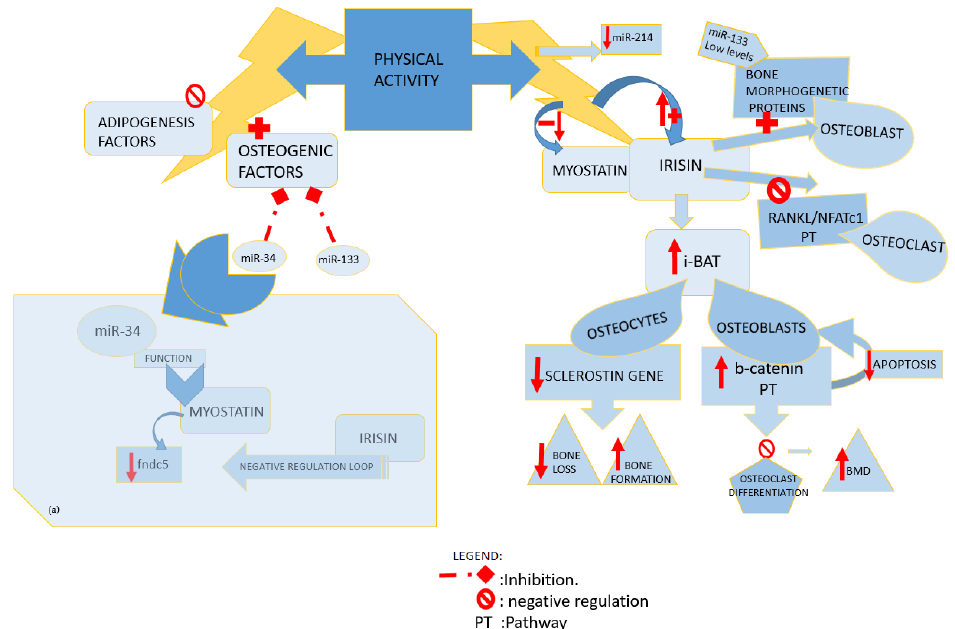
Figure 2. Influence of physical activity. ( a ) miR34 function. miR: microRNA; fndc5: fibronectin type III domain- containing protein 5; RANKL: receptor activator of NFκB ligand; NFATc1: nuclear factor of activated T cells; i- BAT: induced adipose tissue browning; BMD: bone mineral density; PT: path- way.